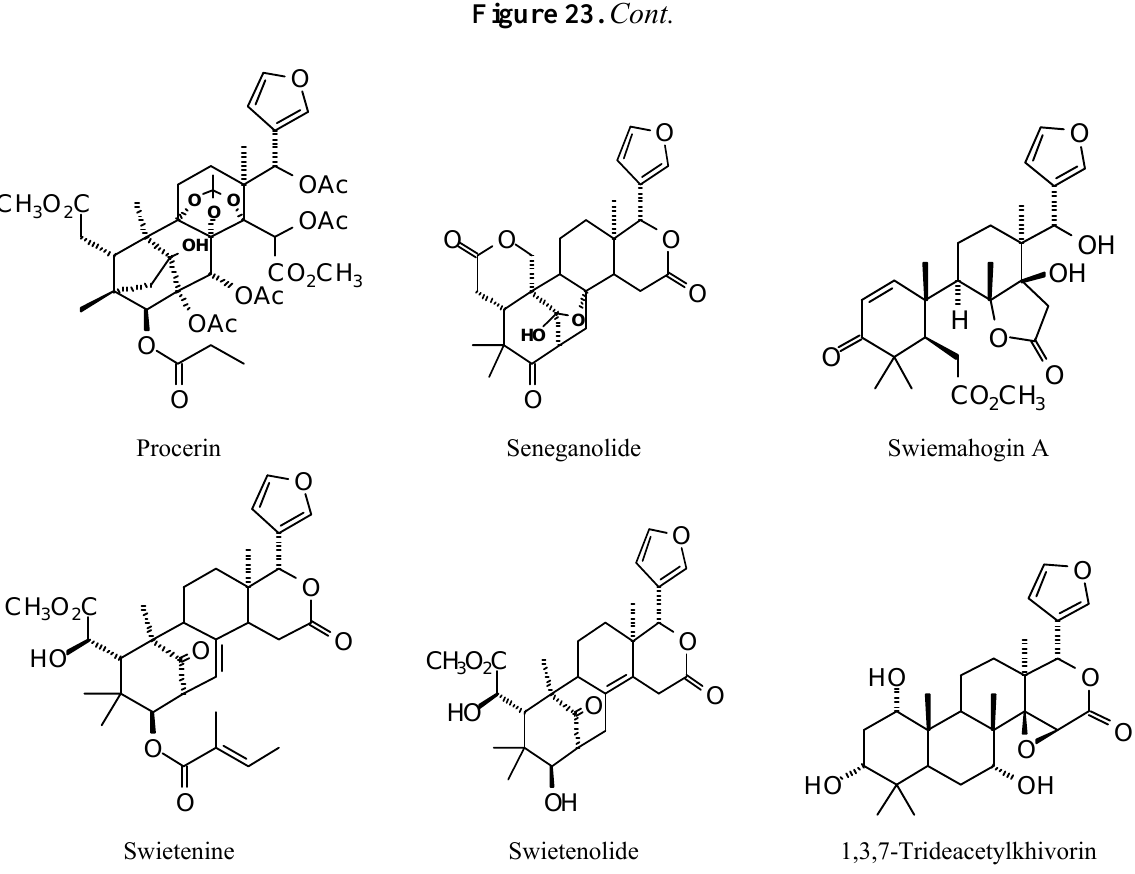
Figure 24. Withanolides examined in this